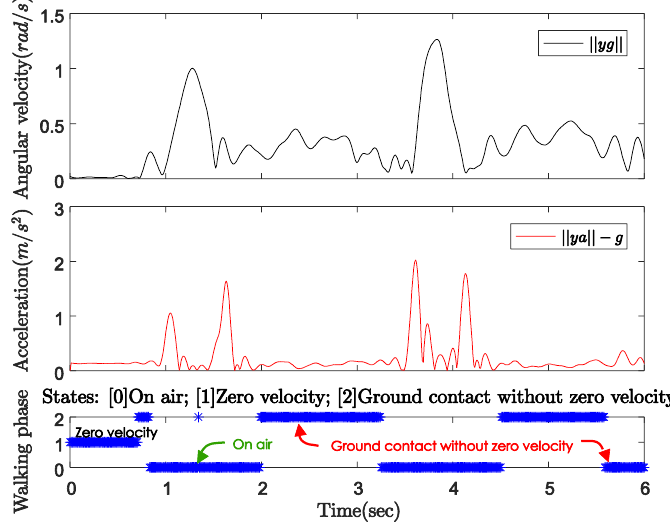
Figure 19. Standard cane’s output data and activity classification.